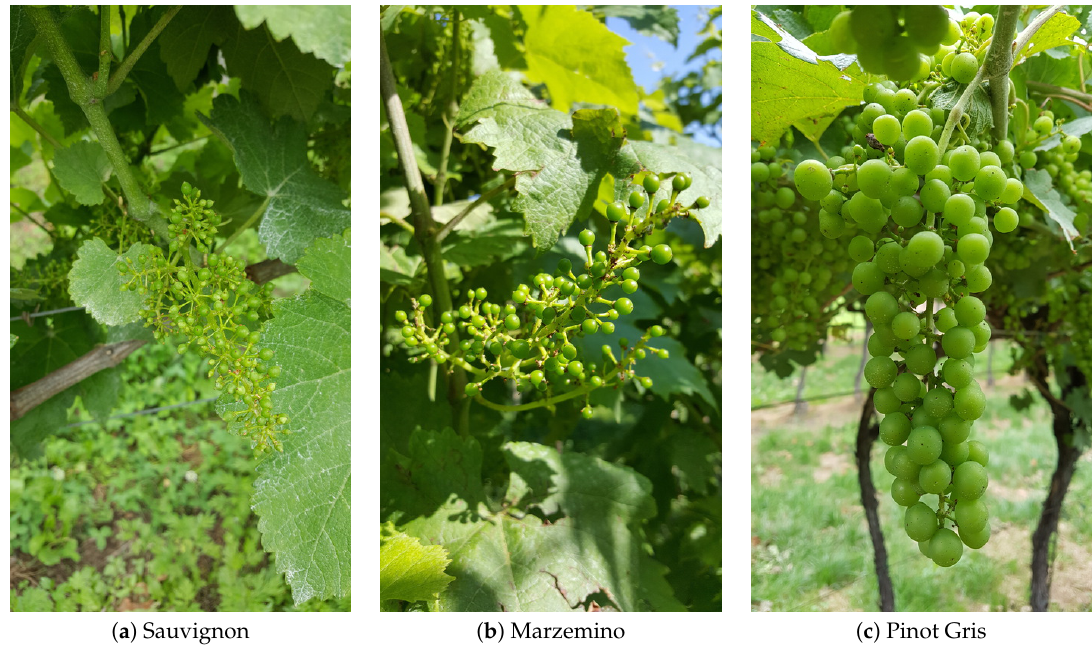
Figure 6. CR1 images are collected during the same time period but with different phenological stages depending on the variety. Pictures are sorted by development stage, from less ( a ) to intermediately ( b ) to most ( c ) developed from left to